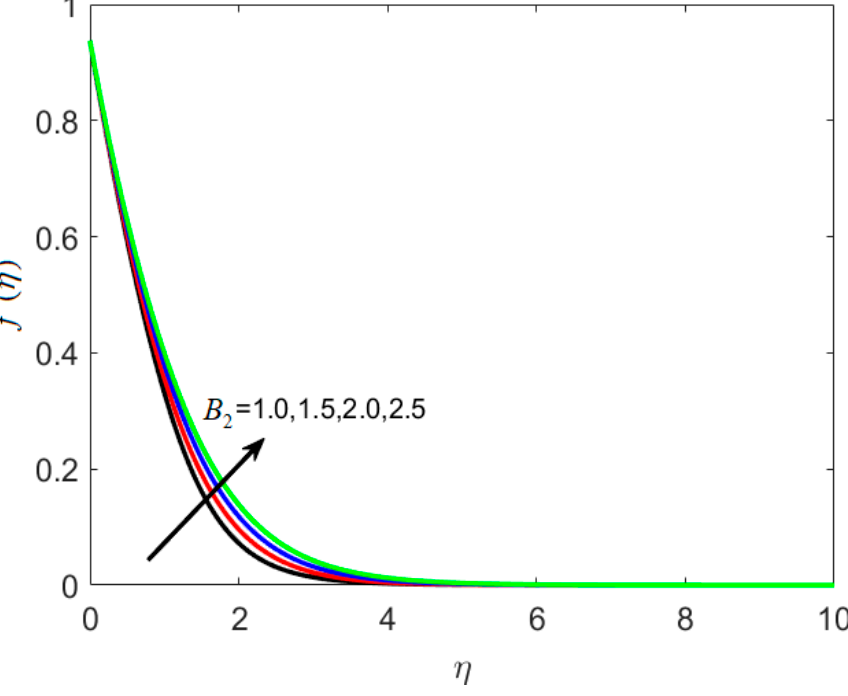
Figure 3. Various estimates of second material parameter 2